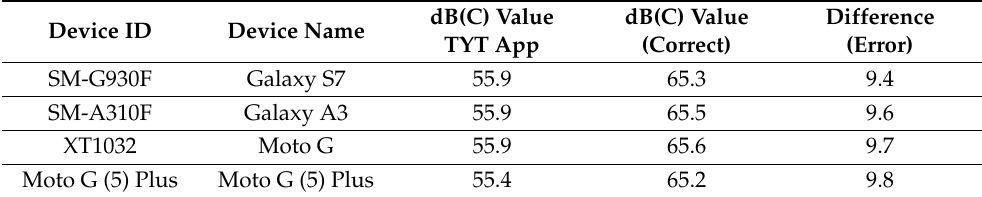
Figure 4. Fitted regression curves for the measured sound levels of the different device models. The x-axis is logarithmically scaled, resulting in linear curves. Table 6. Worst case errors due to the erroneous calculation of the TYT app for the dB(C) values used in the experiments.